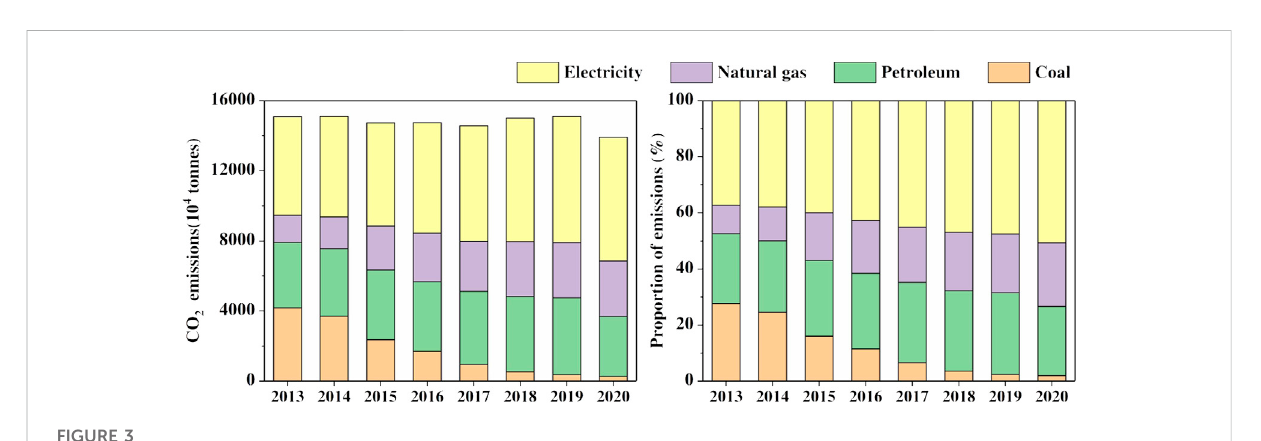
FIGURE 3 Changes in CO 2 emissions and proportions of CO 2 emissions in